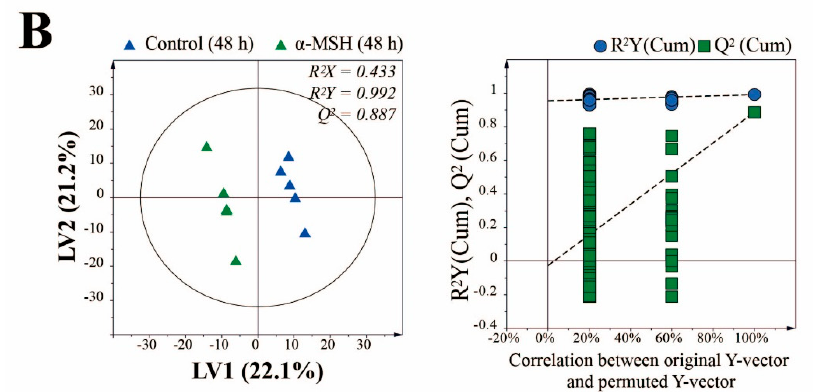
Figure 2. ( A ) PCA score plots derived from GC-MS data at 1, 24 and 48 h of melanoma cell culture. ( B ) partial least squares-discriminant analysis (PLS-DA) score plot between control and α -MSH treated group after 48 h of incubation validated by a permutation test. Table 1. Significantly di ff erent metabolites between the control and α -MSH treated groups, after 48 h of incubation of melanoma cells.